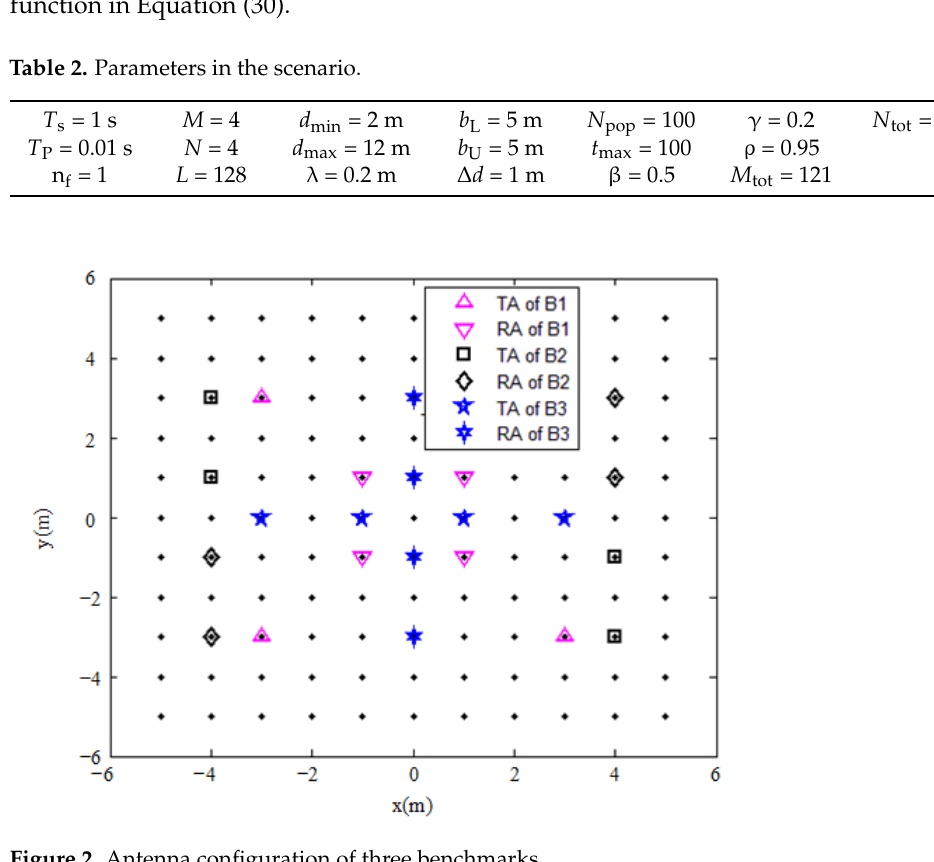
Figure 2. Antenna configuration of three benchmarks.